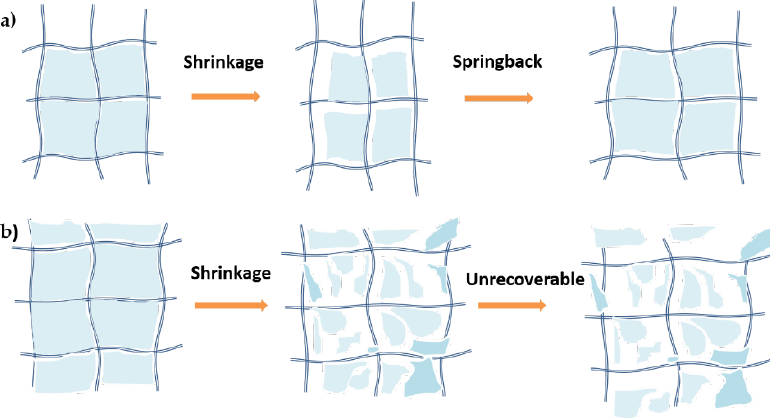
Figure 9. Schematic diagram about recovered and irreversible process of the ethanol-SPD ( a ) and CO 2 - SPD ( b ) fiber-reinforced silica aerogel. CO 2 -SPD ( b ) fiber-reinforced silica